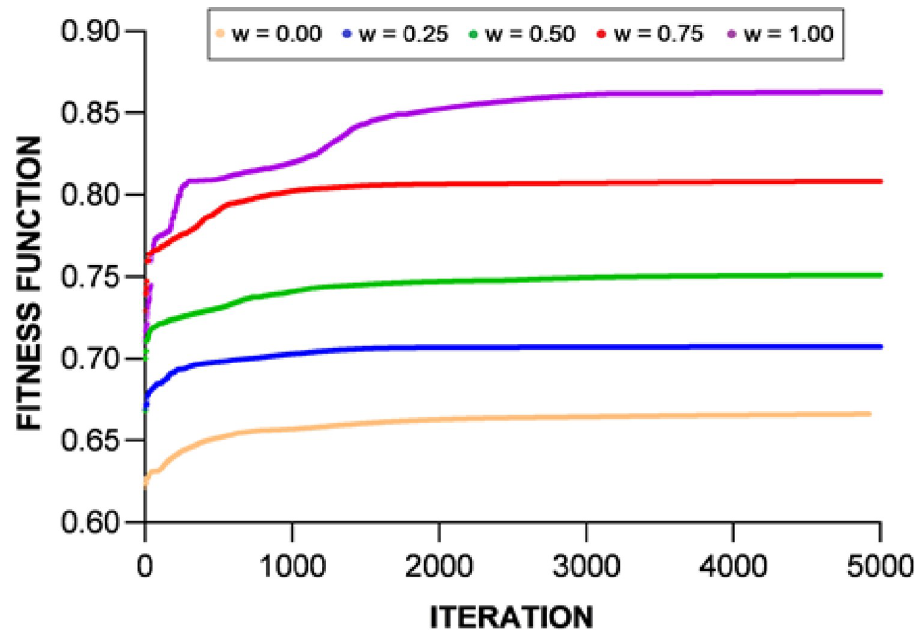
Fig 15. The convergence of the values of the fitness function in five scenarios under the DC priority operation mode.